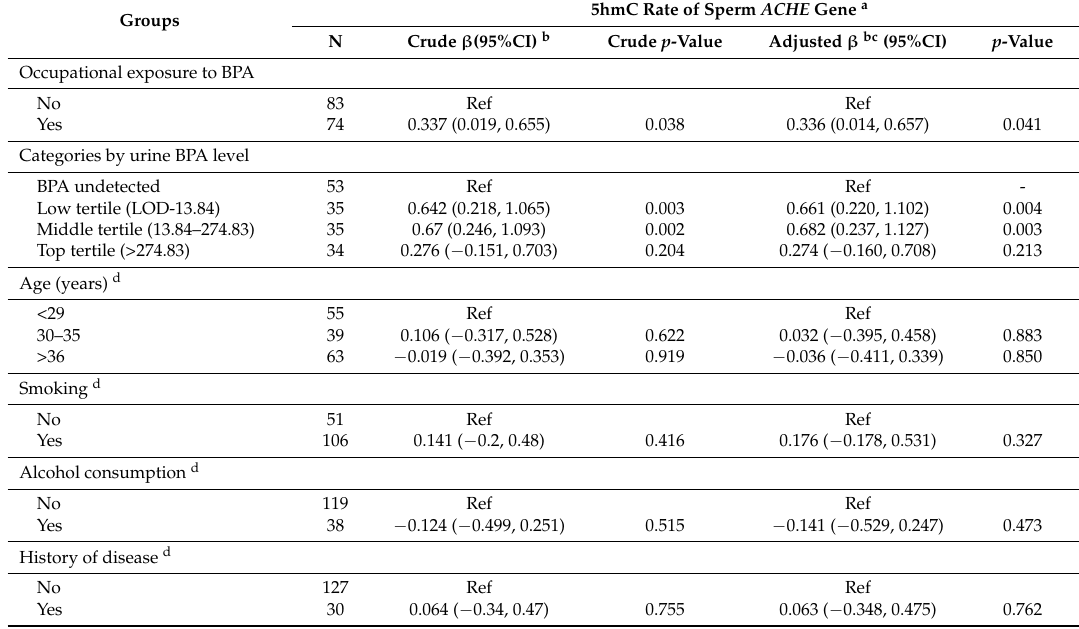
Table 3. Linear regression of BPA exposure and the 5hmC rate of the ACHE gene.